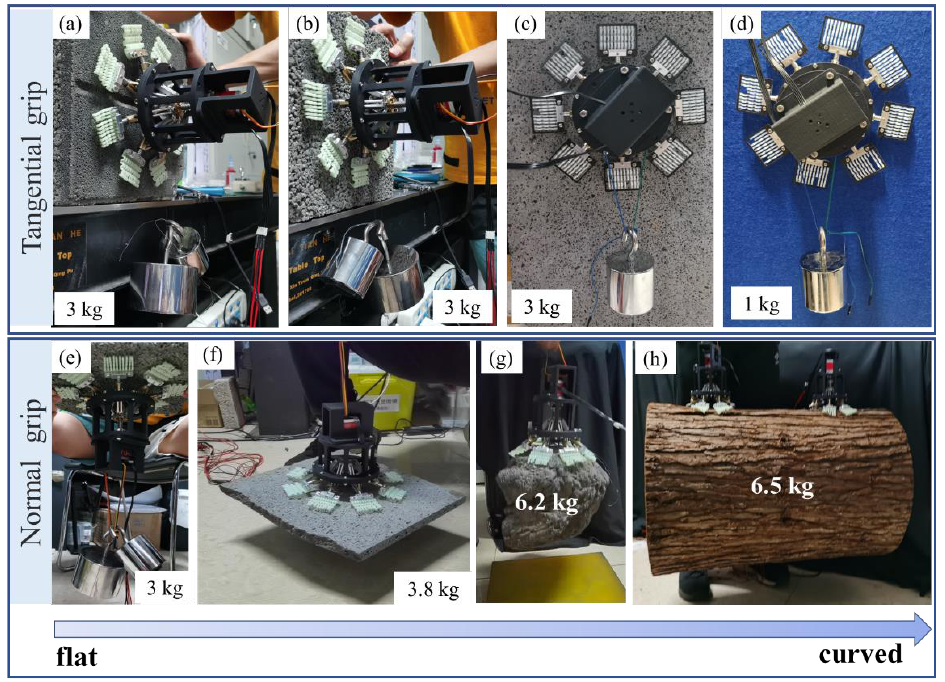
Figure 10. Tangential and normal grasping demonstration of microspines gripper on different surfaces. ( a ) Fine brick. ( b ) Coarse brick. ( c ) Granite. ( d ) Fabric. ( e ) Coarse brick. ( f ) Granite. ( g ) Rock. ( h ) Trunk.